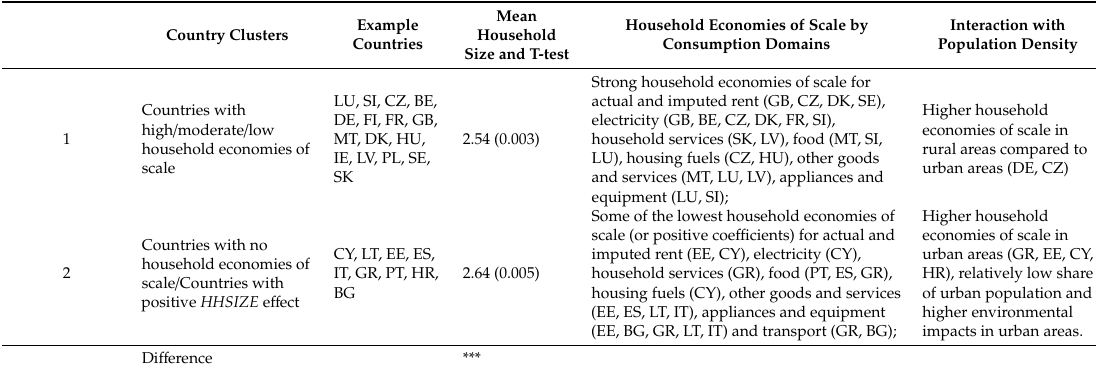
Table 2. A summary of country clusters with regards to household economies of scale and other contextual di ff